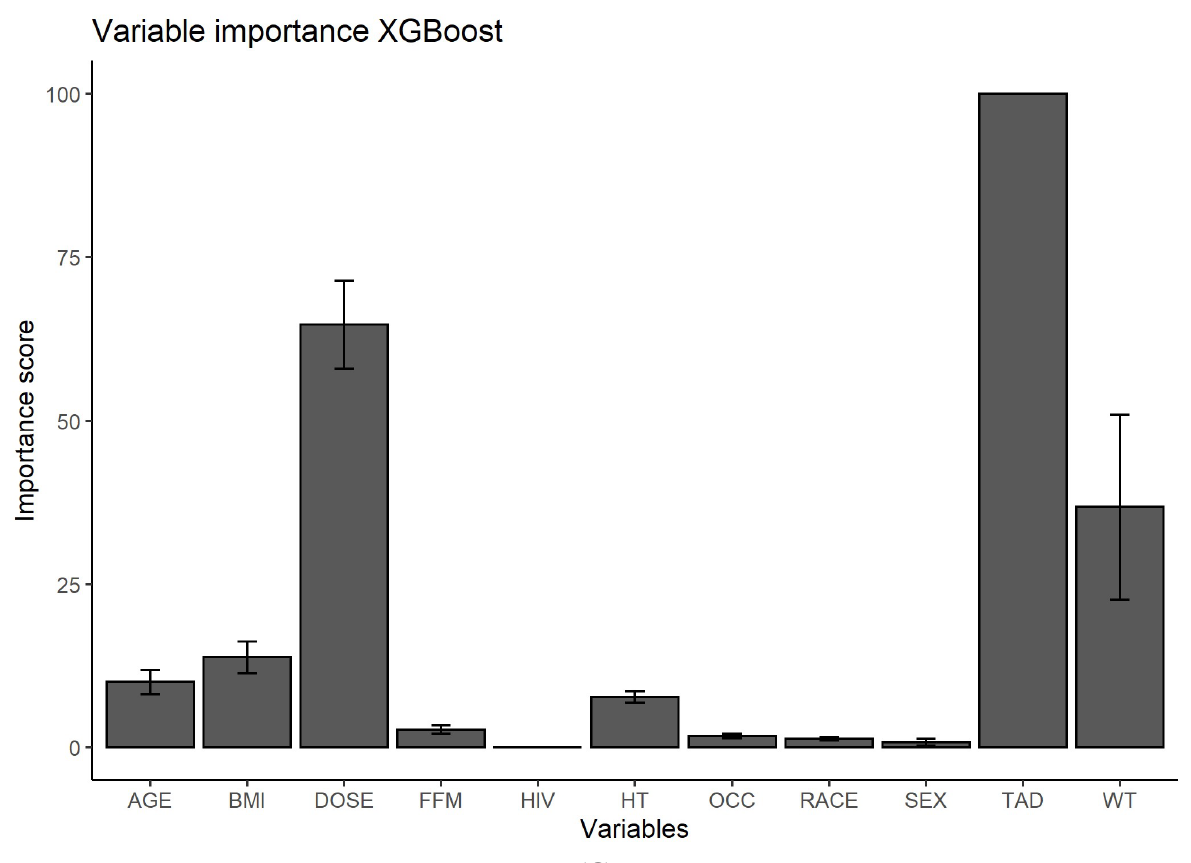
Figure 4. Importance scores for evaluated features shown for the different machine learning algo- rithms. ( A ) GBM, ( B ) Random Forest and ( C ) XGBoost using features only (scenario 1) as input for prediction of plasma concentration versus time. The error bars represent the standard deviation. AGE, age (years); BMI, body mass index (kg/m 2 ); DOSE, daily rifampicin dose (mg); FFM, fat-free mass (kg); HIV, HIV-coinfection; HT, body height (cm); OCC, treatment week; RACE, race; SEX, gender; TAD, time after dose (h); WT, bodyweight (kg).